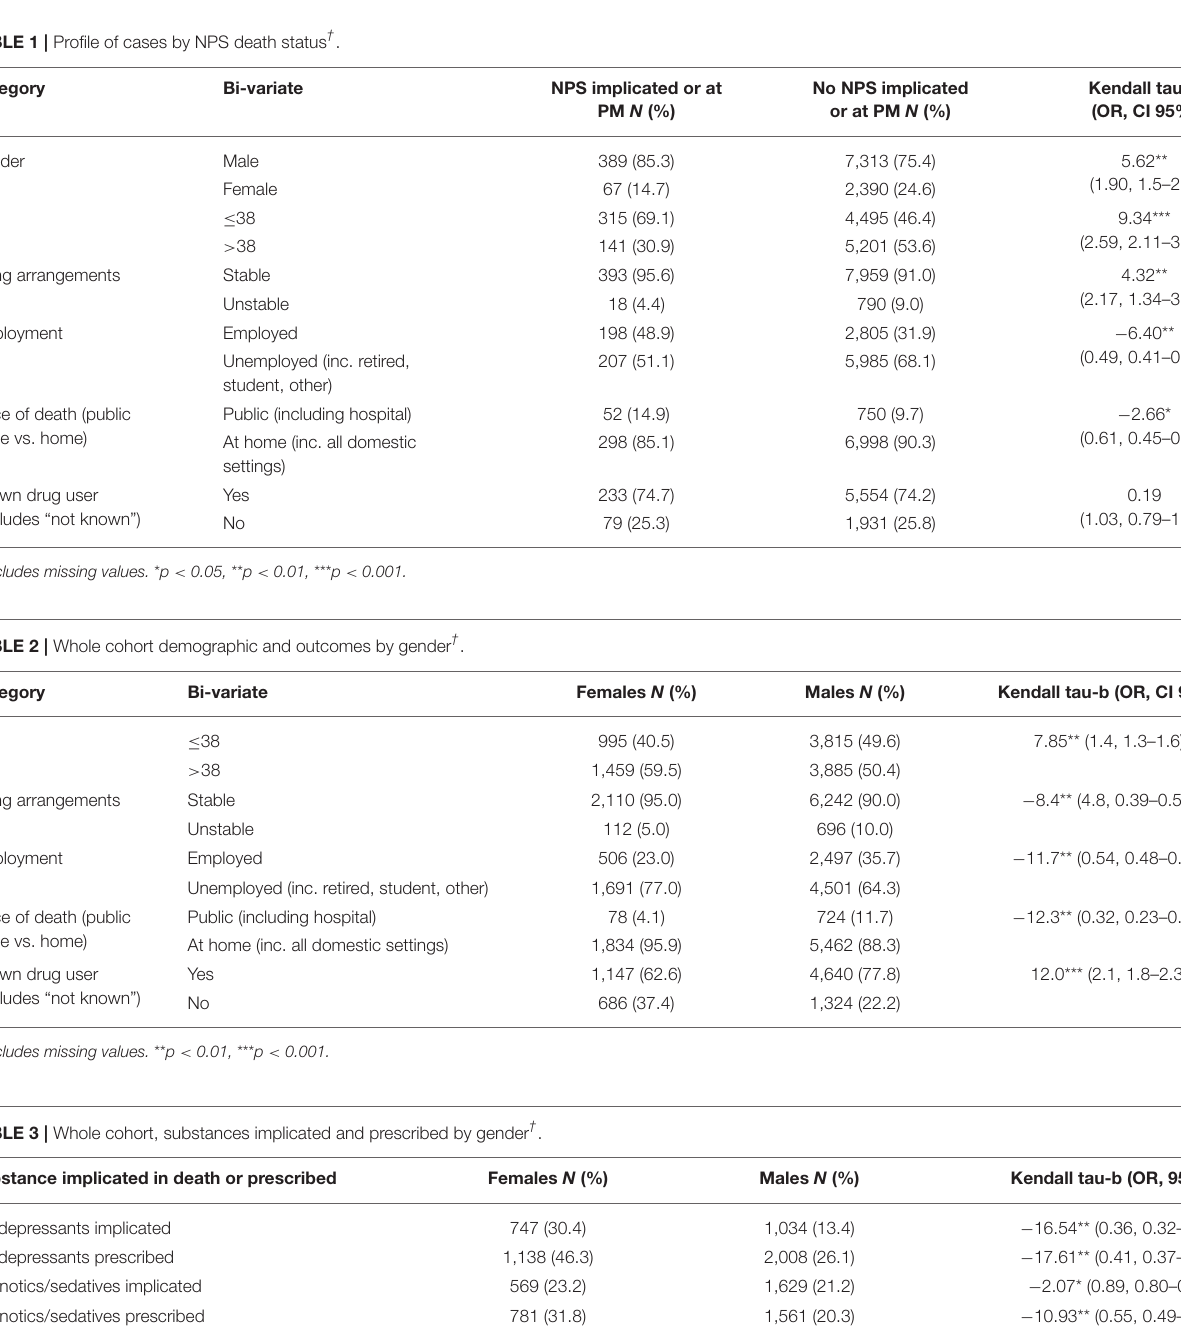
TABLE 1 | Profile of cases by NPS death status † .